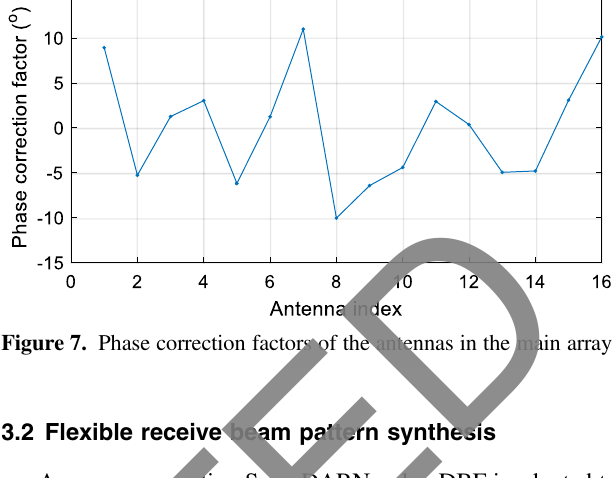
Figure 7. Phase correction factors of the antennas in the